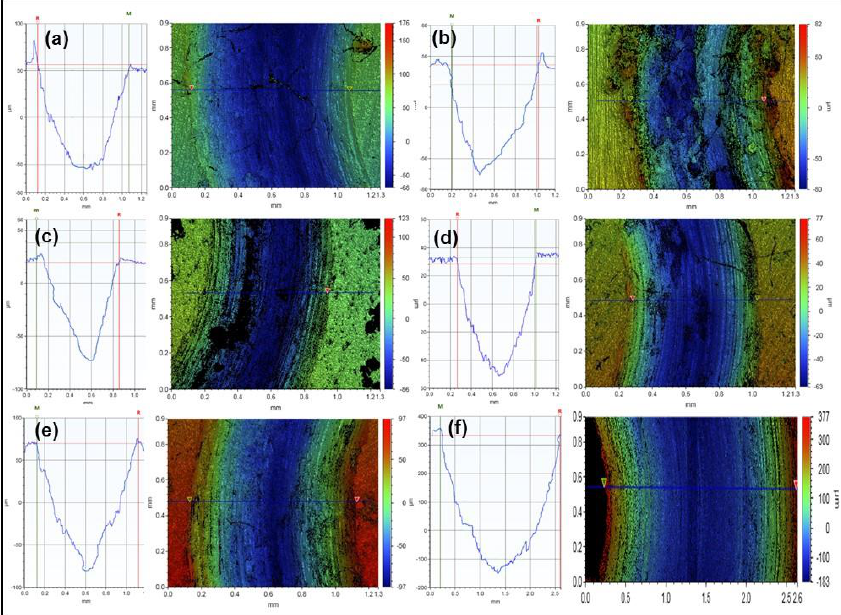
Figure 3. Typical 2D profiles for wear tracks after the wear test at a load of 3 N, sliding speed of 0.1 m/s and a sliding distance of 100 m: ( a ) Pure Al; ( b ) Al-0.25 wt% GO; ( c ) Al-10 Vol% Al 2 O 3 ; ( d ) Al-10 Vol% Al 2 O 3 -0.25 wt% GO; ( e ) Al-10 Vol% Al 2 O 3 -0.5 wt% GO; ( f ) Al-10 Vol% Al 2 O 3 -1 wt% GO. For the hybrid nanocomposites, the specific wear rate decreased slightly further upon adding 0.25 wt% GO to Al-10 Vol% Al 2 O 3 , owing to the improved hardness of the hybrid